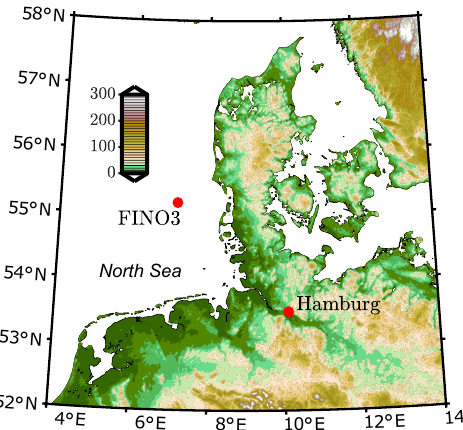
Figure 2. Map of northern Europe with the location of the offshore (FINO3) and onshore (Hamburg) sites as red dots. The colorbar indicates the height in meters above sea